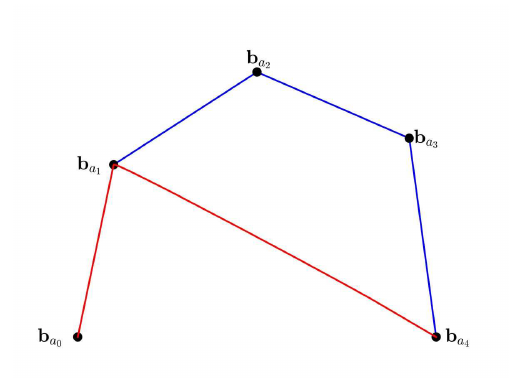
Figure 10: Limit of GT-Bézier curve with ω a 1 → +∞